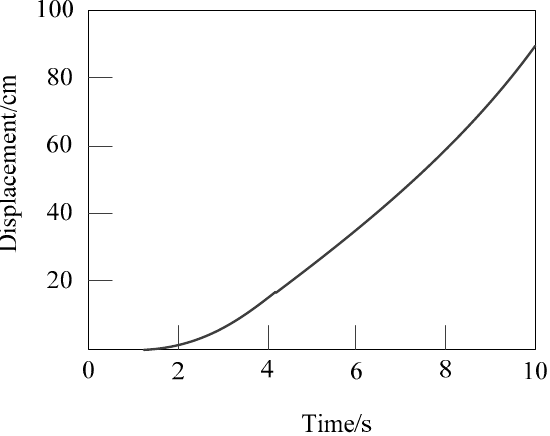
Figure 9. Displacement and time curve of the piston-rod’s extension of the no-load boom.